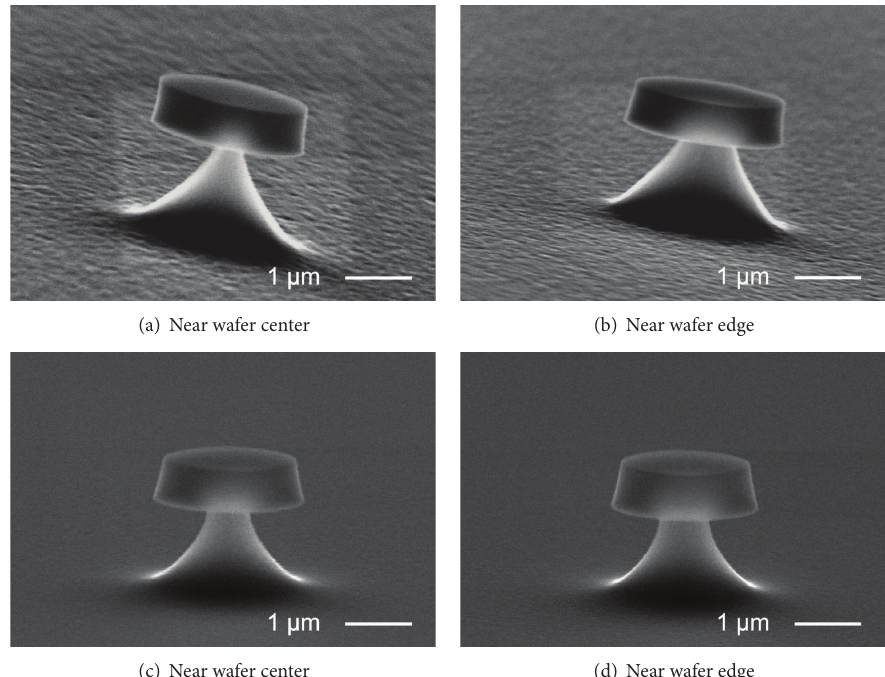
Figure 8: SEM images of the emitters after RIE of Si at different etching parameters: (a) and (b) 90 mTorr, 60s, 90 W, (c) and (d) 50 mTorr, 90 s, 90W.